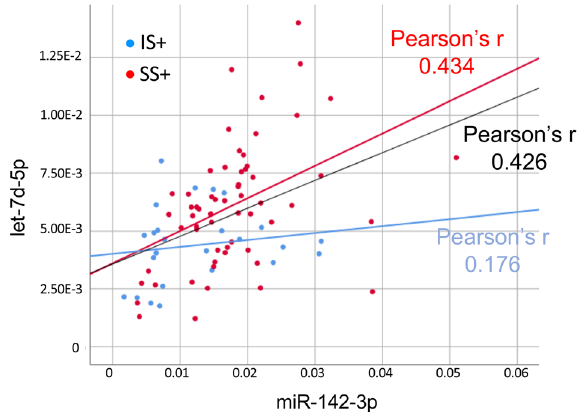
Figure 2. Correlation between miR-142-3p and let-7d-5p. Measurements of miR-142-3p and let-7d-5p from individual participants in IS + and SS + were plotted. Data from participants in IS + and SS + groups are shown in blue and red dots, respectively. Blue, red, and black lines indicate linear correlations in IS + , SS + , and combined groups,